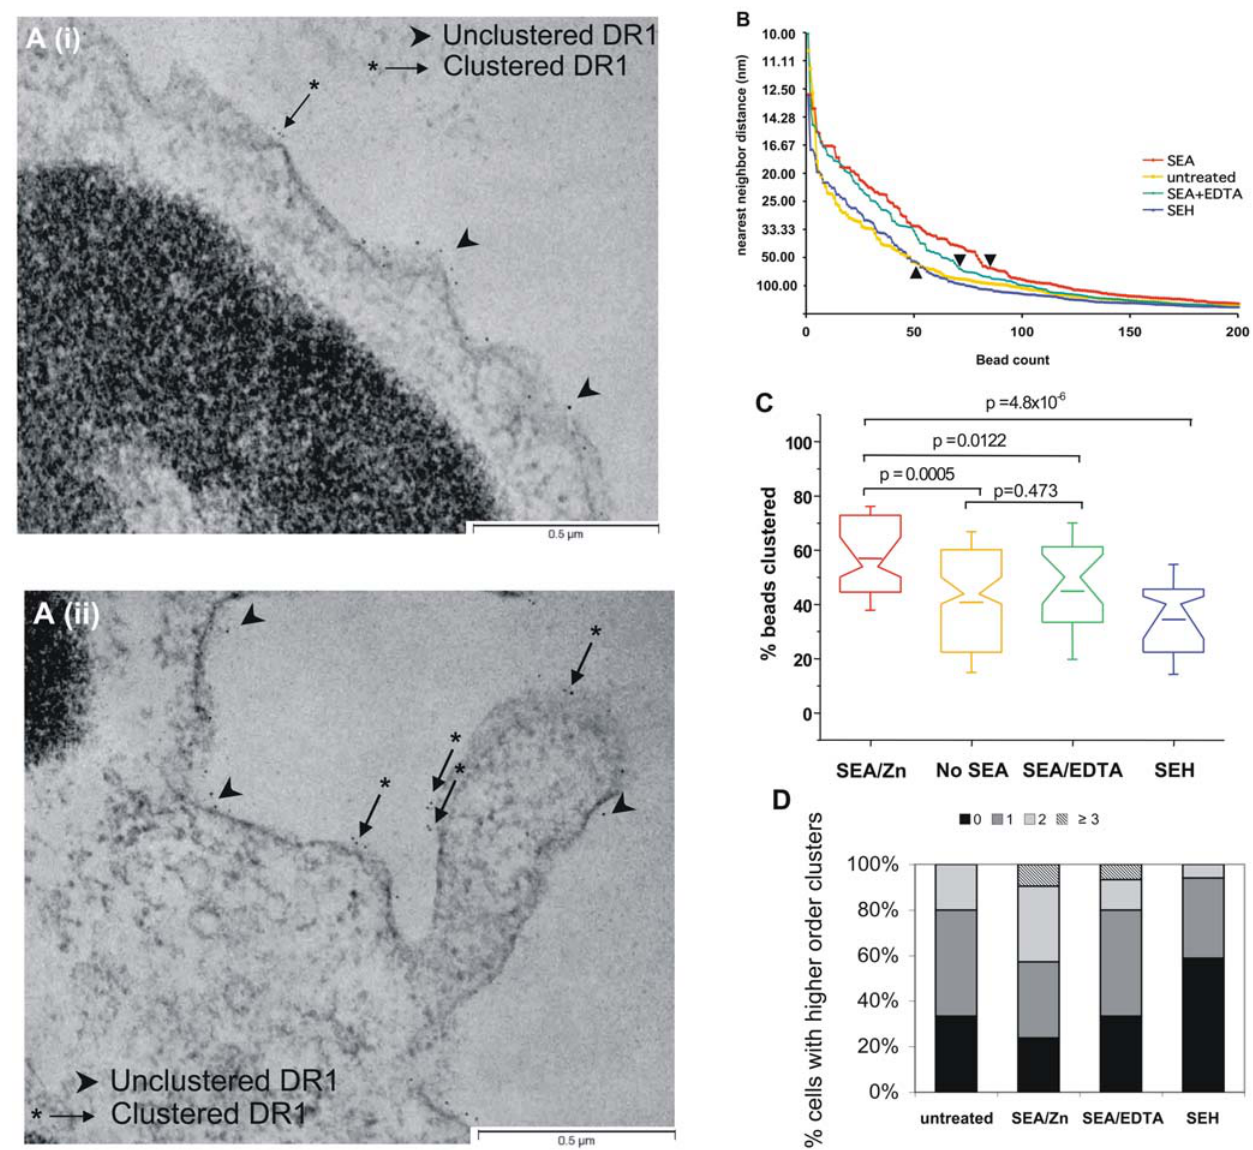
Figure 4. SEA induces small clusters of HLA-DR1 on the B cell surface. B cells were treated, stained and fixed as in Figure 3, and thin sections (80 nm) analyzed by transmission electron microscopy. (A) Images of untreated B cells (i) or B cells treated with 2.5 m g SEA (ii) showed varying degrees of clustering of HLA-DR1. arrow/asterisk, ‘‘clustered’’ gold beads; arrowhead, ‘‘unclustered’’ gold beads. (B) Nearest neighbor analysis of B cells treated with SEA ( red ) shows an increased number of closely apposed gold beads compared to B cells treated with no enterotoxin ( yellow ) or SEH ( blue ). SEA + EDTA ( green ) has an intermediate distribution, and these differences disappear when nearest neighbors are separated by large distances. m , separation at 75 nm. (C) B cells treated with SEA show a statistically significant increase in the fraction of beads that are within 75 nm of each other, when compared to cells that were untreated or treated with SEH or SEA + EDTA. Same color scheme as above. (D) SEA treatment does not mediate higher order aggregation of HLA-DR1. Equivalent stretches of B cell membranes of various groups were evaluated for number of instances of ‘‘higher order’’ clusters (clusters of . 2 gold beads). There was an increase in the fraction of cells with higher order clusters on SEA treatment, but no dramatic change in the distribution profile between the groups. Data pooled from two